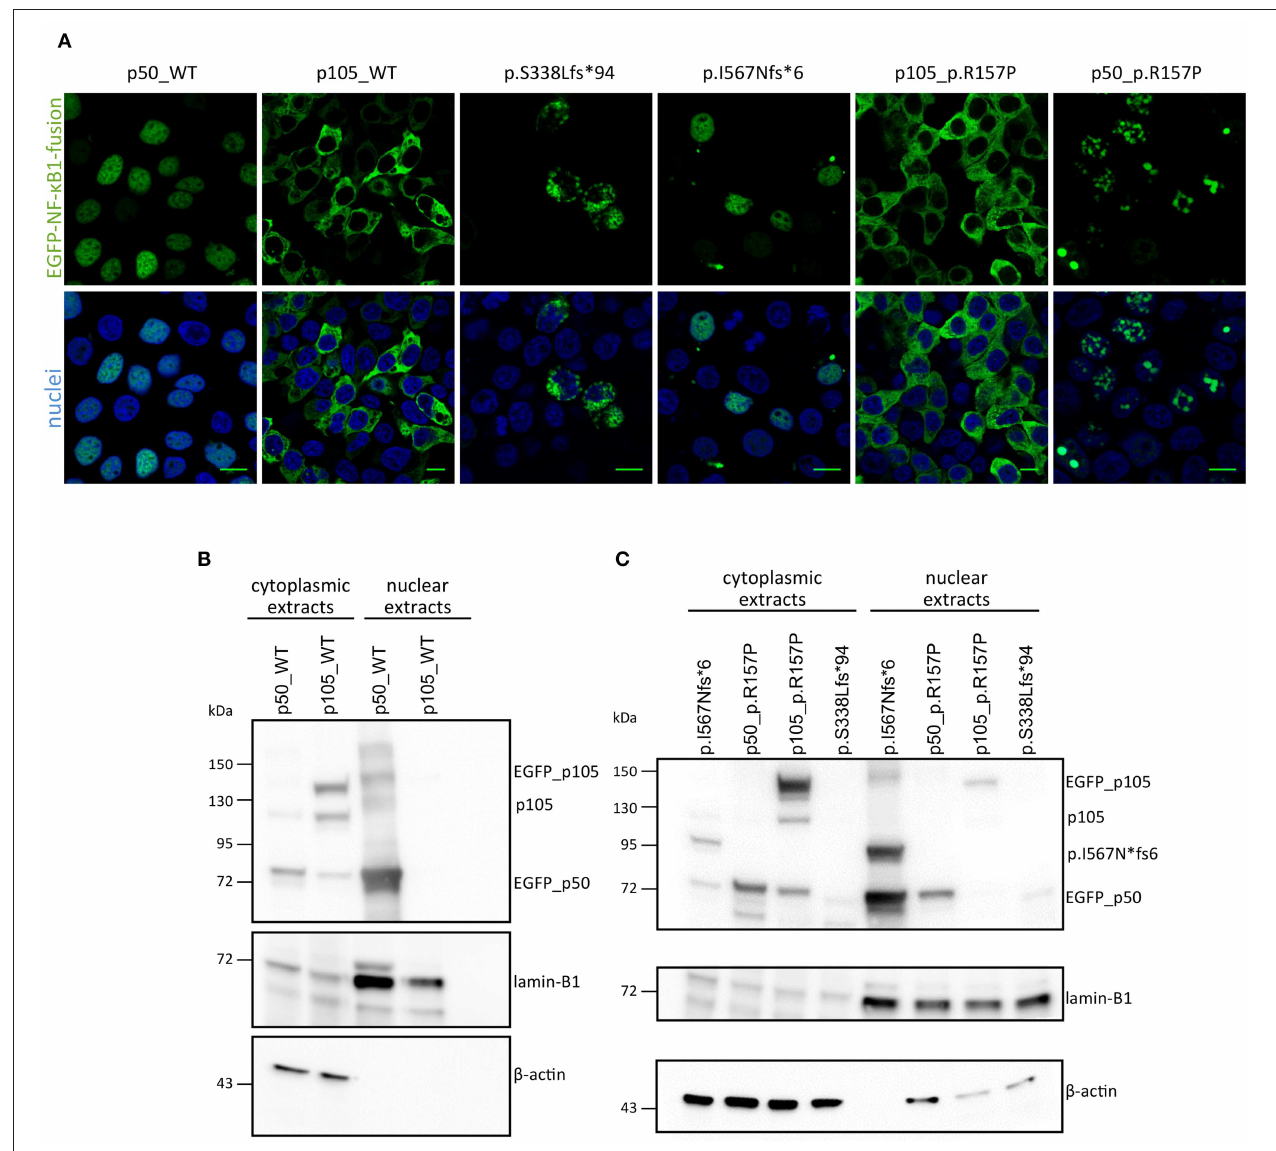
FIGURE 3 | Overexpression assay of EGFP-fused NF- κ B1 proteins. (A) HEK293T cells were transiently transfected with EGFP-fused mutant proteins or EGFP-fused wildtype proteins. Scale bars represent 10 µ m. Immunoblots with in either nuclear or cytoplasmic fraction of transiently transfected HEK293T cells with N-terminally EGFP-tagged p50-WT or p105-WT (B) or mutant-constructs ( C ; as indicated) were analyzed for p105 and p50 amounts. ß-actin was used as a cytoplasmic loading control and lamin-B1 for nuclear loading